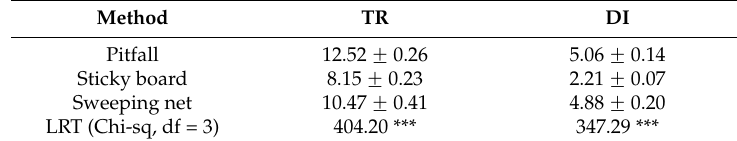
Table 7. Average ± se, taxonomic richness (TR) and diversity index (DI) per sampling method. LRT Table 7. Average ˘ se, taxonomic richness (TR) and diversity index (DI) per sampling method. LRT based on complete model (Table S7e,f); *** p < 0.001. based on complete model (Table S7e,f); *** p < 0.001.